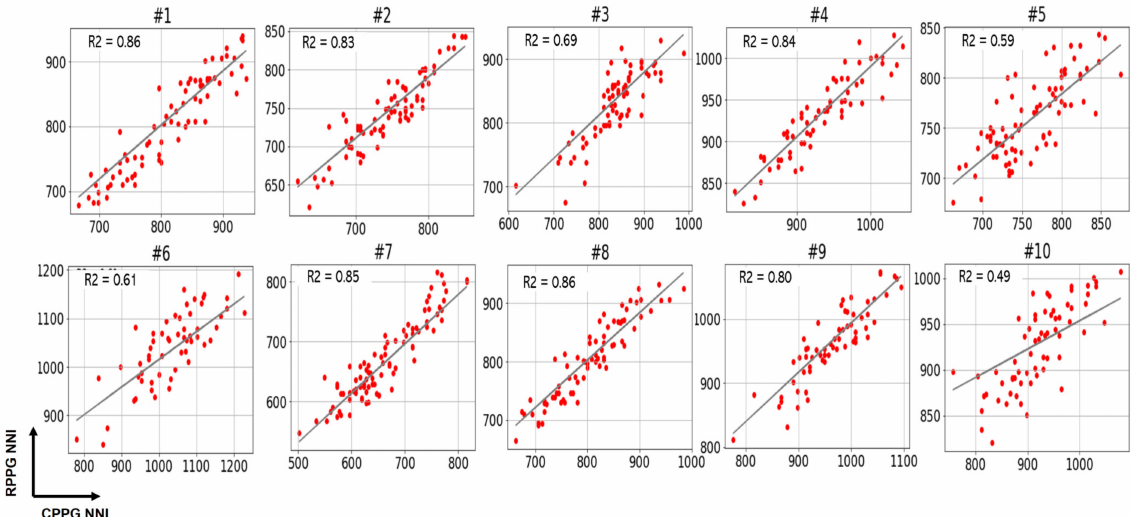
Figure 6. Plots for the analysis of correlations between two NNIs of contact photoplethysmography (CPPG) and remote PPG (RPPG) for 10 subjects.